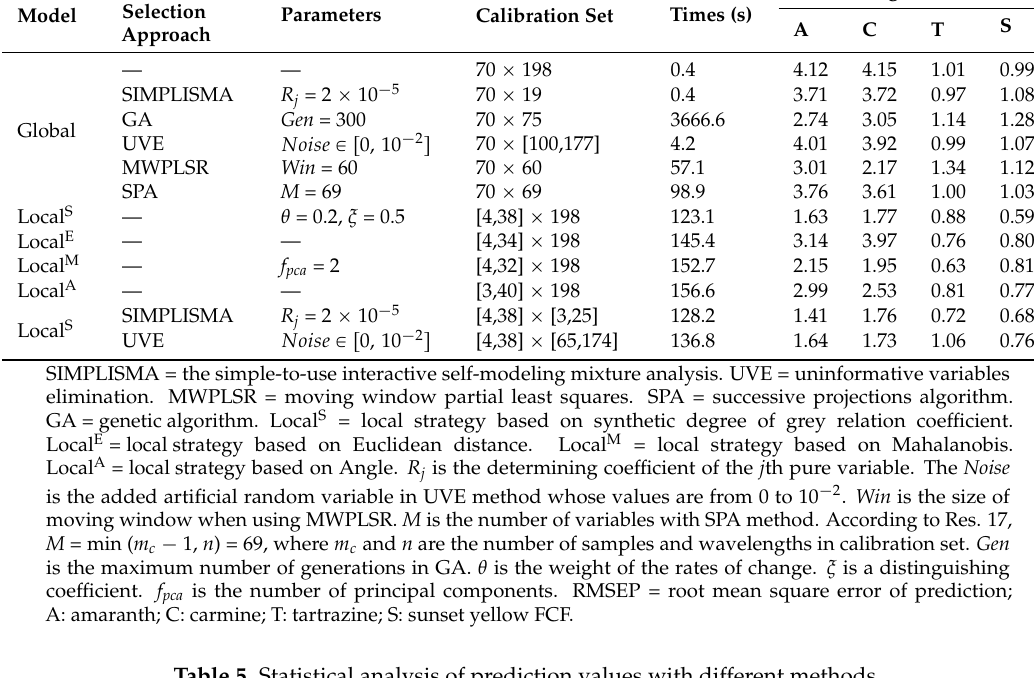
Table 5. Statistical analysis of prediction values with different